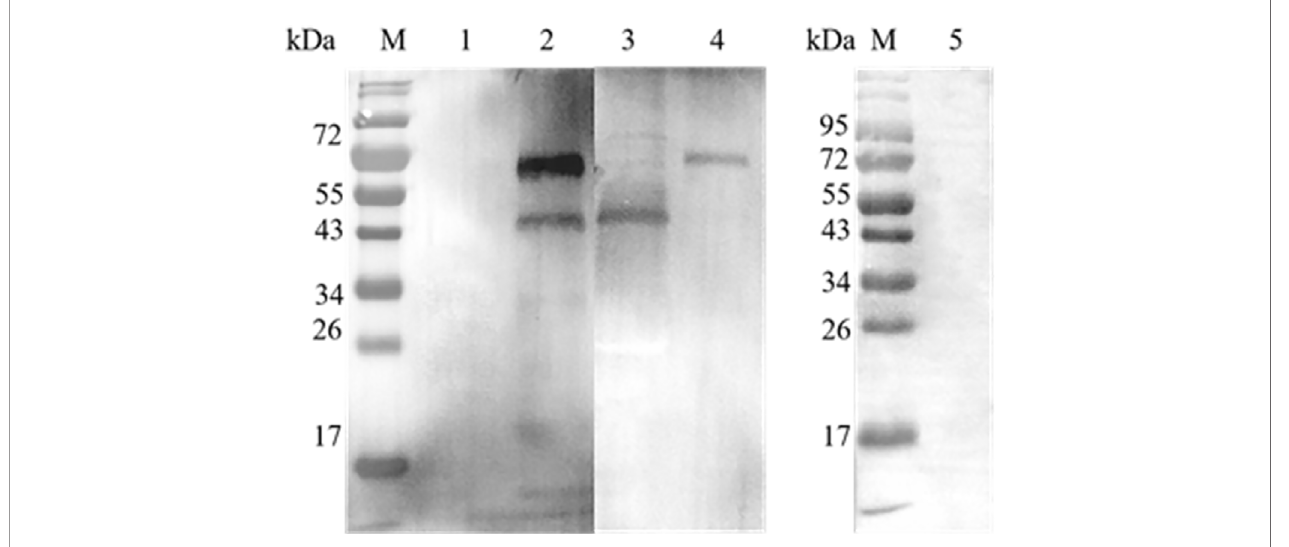
FIGURE 4 | Analyze the results of GST pull down by Western blot. M, Molecular weight marker. Lane 1, glutathione S-transferase (GST)-tag incubated with r Et CDPK4, detected with anti-r Et eIF-5A and anti-r Et CDPK4 rabbit serum as a negative control; Lane 2, r Et CDPK4 incubated with r Et eIF-5A, detected with anti- r Et eIF-5A and anti-r Et CDPK4 rabbit serum as the sample group; Lane 3, puri fi ed protein of r Et eIF-5A probed with anti-r Et eIF-5A and anti-r Et CDPK4 rabbit serum; Lane 4, puri fi ed protein of r Et CDPK4 probed with anti-r Et eIF-5A and anti-r Et CDPK4 rabbit serum; Lane 5, PBS with r Et eIF-5A loaded in an empty glutathione- agarose column, detected with anti-r Et CDPK4 rabbit serum and anti-r Et eIF-5A rabbit serum as a blank control.